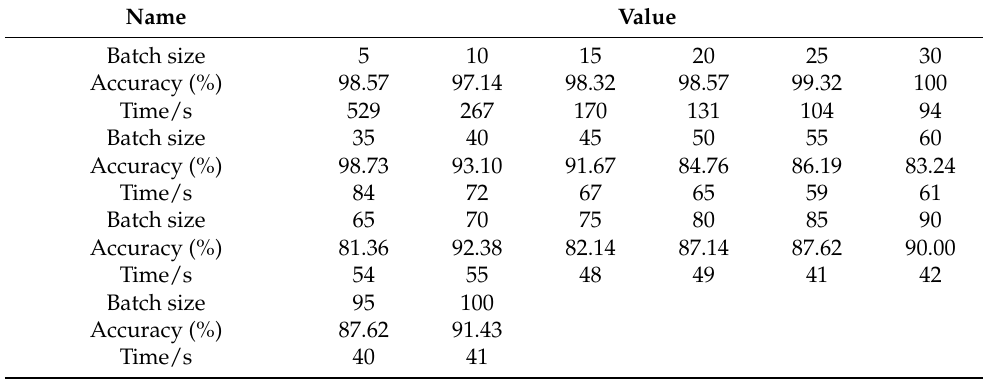
Figure 6. Obtained accuracy for different learning rate values. Table 4. Results for different batch size values.